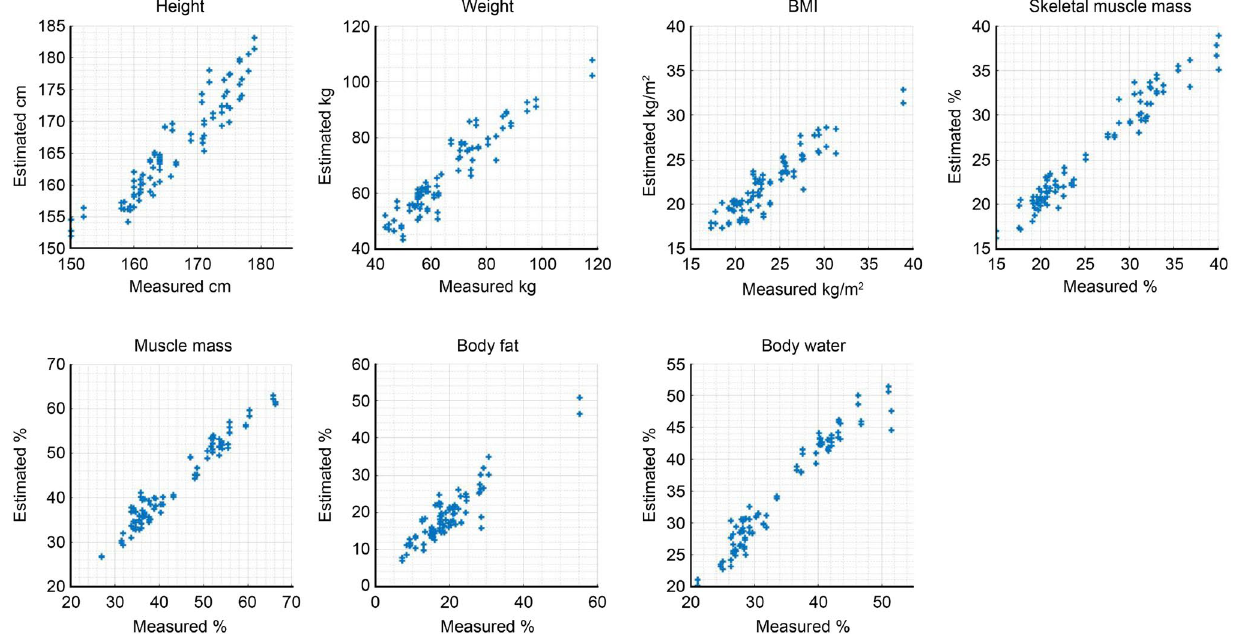
Figure 7. Comparison of estimation values and measured values of anthropometric parameters.